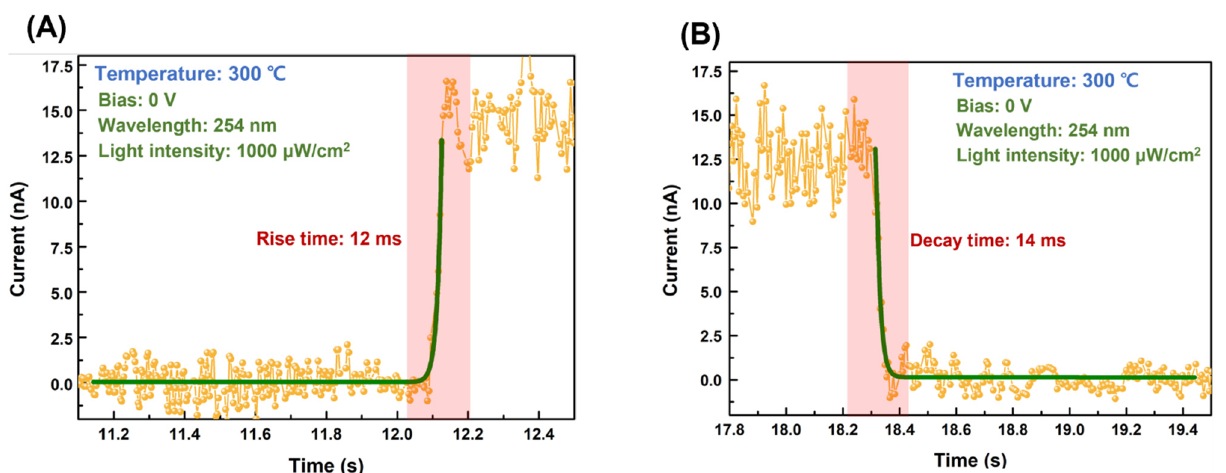
Figure 7. Part of time-dependent photocurrent of the CuO/ β -Ga 2 O 3 heterojunction photodetector for ( A ) rise time and ( B ) fall time at zero bias under 254 nm solar-blind UV light with 1000 µ W/cm 2 light